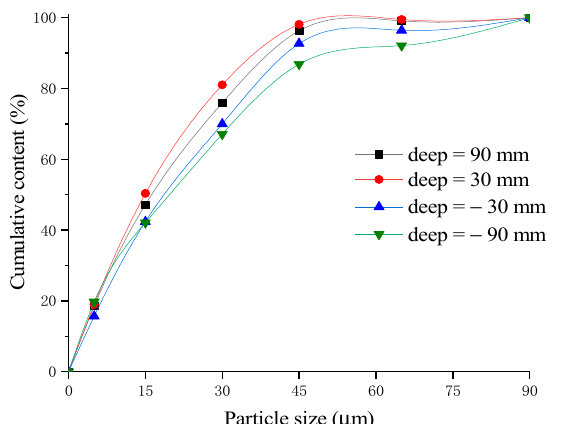
Figure 11. Inner-overflow yield and particle classification for different inner vortex finder insertion depths.